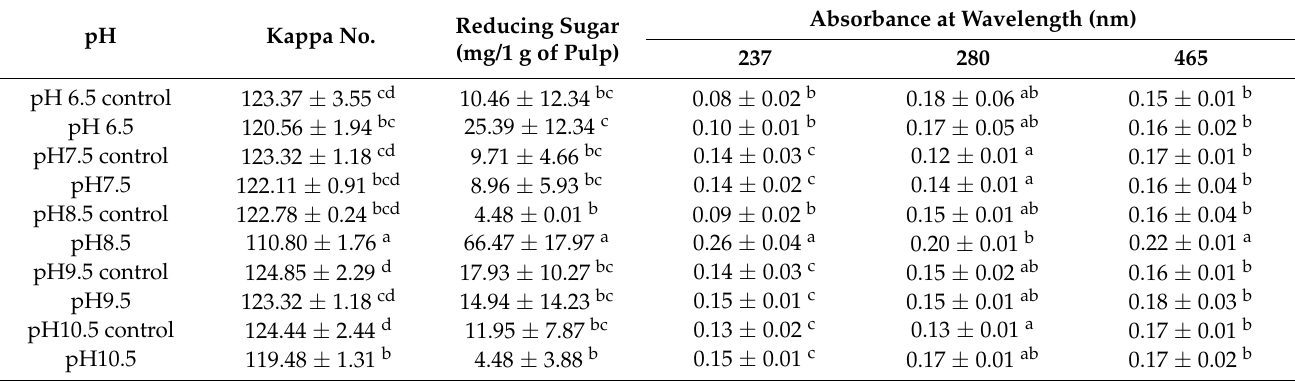
Table 3. Effect of pH on pulp biobleaching.